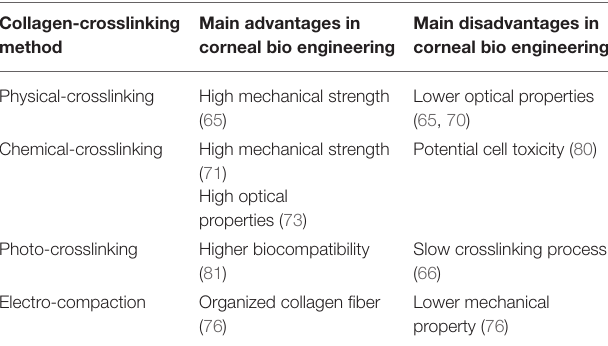
TABLE 2 | Main advantages and disadvantages of Collagen-crosslinking method in corneal bioengineering. Collagen-crosslinking